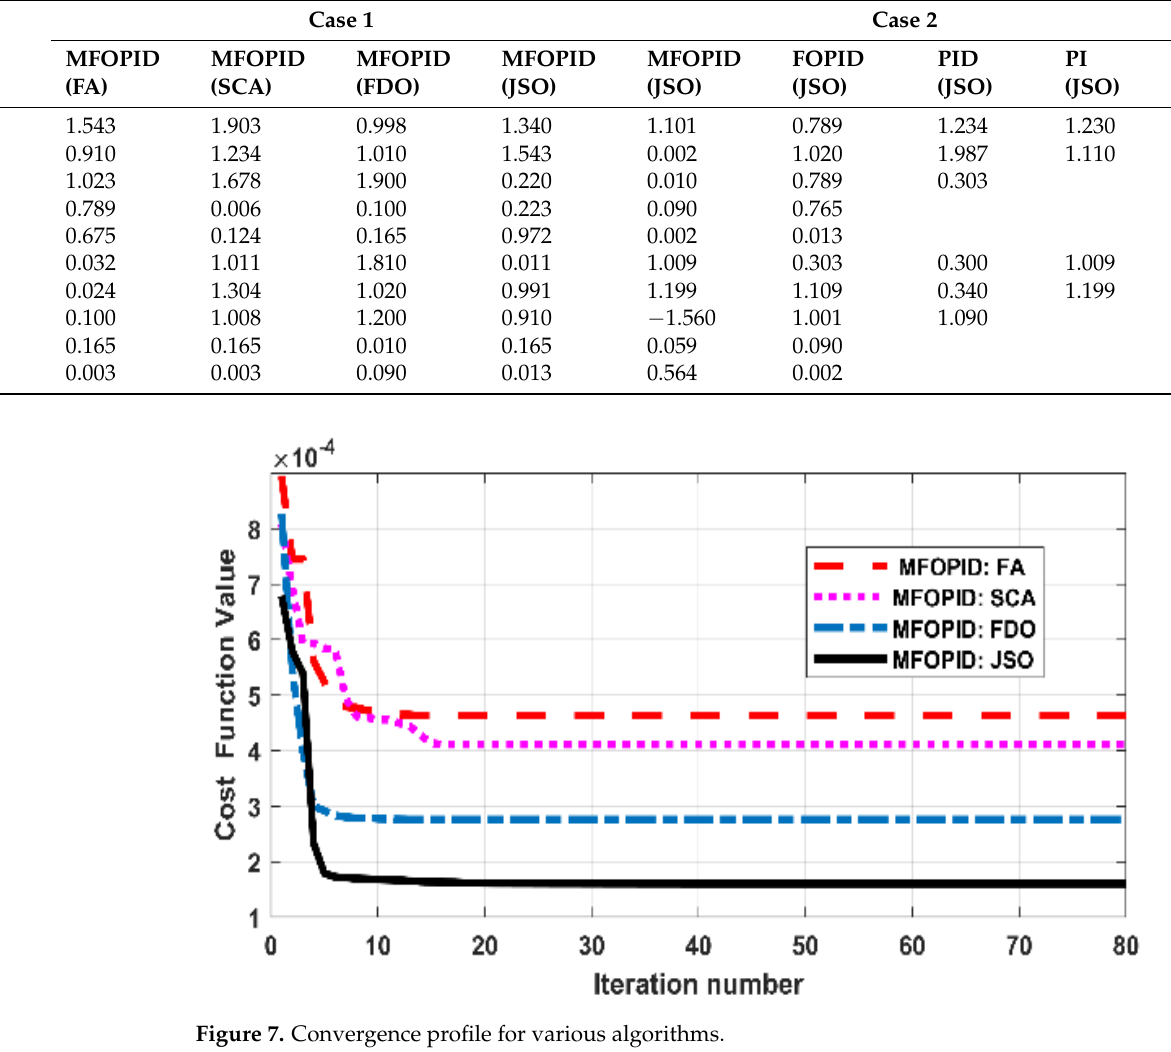
Table 1. Optimal gains of the suggested controller considering case 1 and case 2.